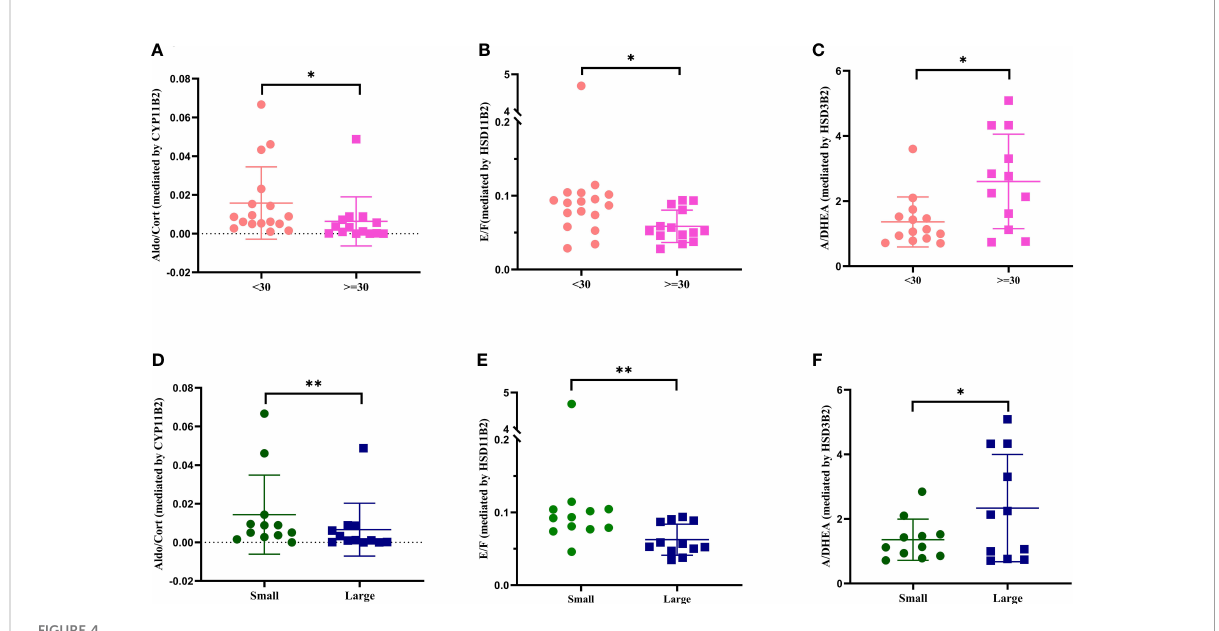
FIGURE 4 Conversion ratio analysis of adrenal vein values based on adrenal volume and radiological asymmetry. Only signi fi cant results are shown. Comparisons of Aldo/Cort between groups based on adrenal volume (A) and radiological asymmetry (D) . Comparison of E/F between groups based on adrenal volume (B) and radiological asymmetry (E) . Comparison of A/DHEA between groups based on adrenal volume (C) and radiological asymmetry (F) . Aldo, aldosterone; Cort, corticosterone; A, androstenedione; DHEA, dehydroepiandrosterone; E, cortisone; F, cortisol. * p <0.05, ** p